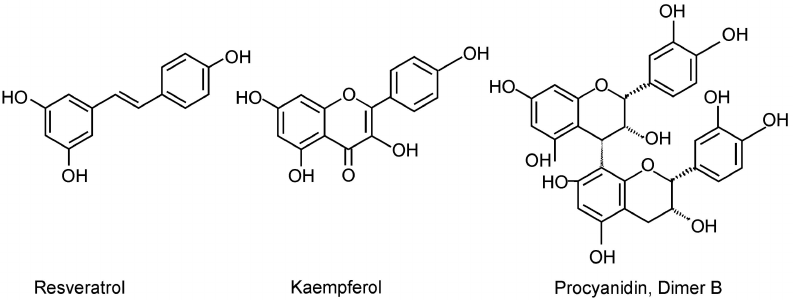
Figure 1. Chemical structures of resveratrol, kaempferol, and proanthocyanidins (procyanidin dimer B as an example).